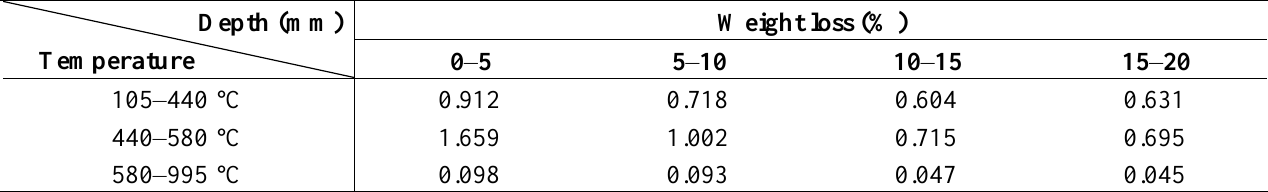
Table 2. Weight loss vs. temperature at various depths.